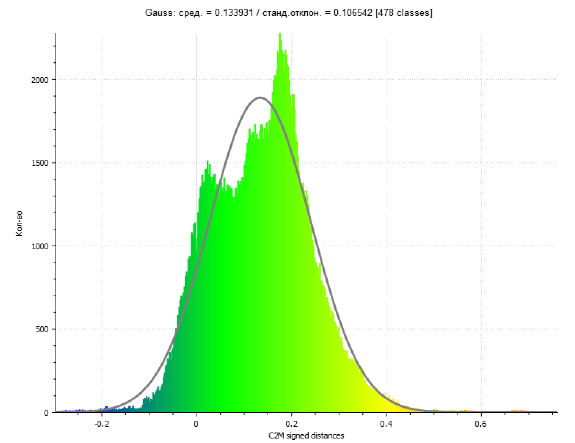
Figure 14. Gaussian distribution plot obtained by analyzing the quality of photogrammetry